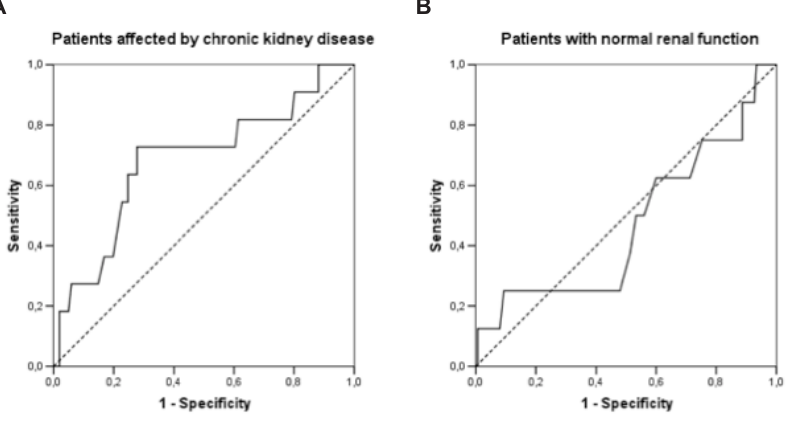
Figure 2. Receiver operating characteristic curve analysis for in-hospital death predicted by serum uric acid levels in patients affected by chronic kidney disease (A) and in patients with normal renal function (B).